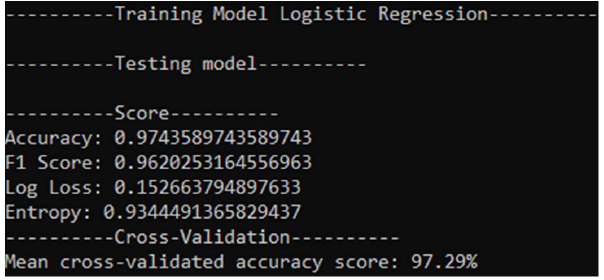
Figure 8. Accuracy of Logistic